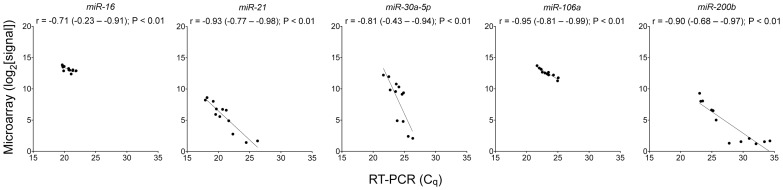
Confirmation of microarray-based microRNA quantifications by reverse transcription-PCR assays.Pearson correlation coefficients (r), P values, and best-fitting (least squares) lines are shown for RT-PCR Cq and log2-transformed microarray signal values for microRNAs miR-16, −21, −30a-5p, −106a, and −200b (n = 12).